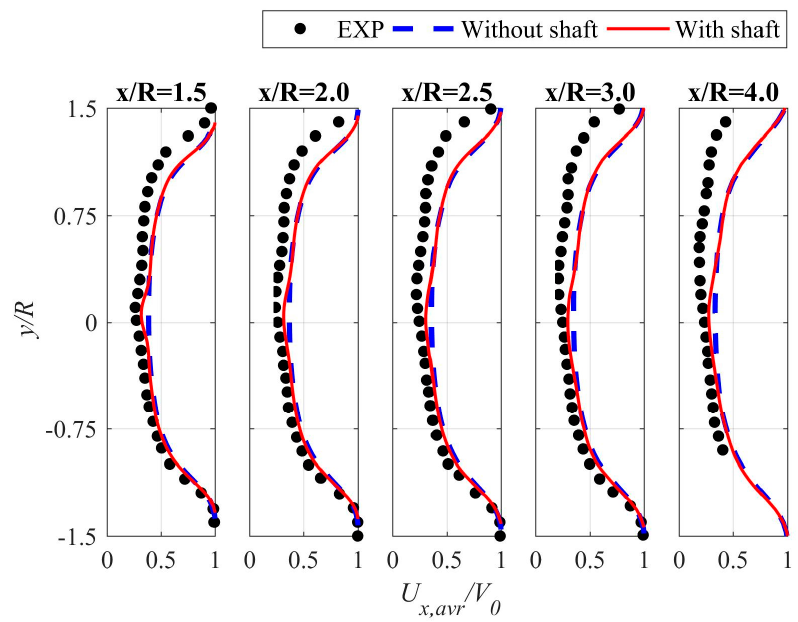
Energies 2019 , 12 , x FOR PEER REVIEW Figure 6. Velocity profiles of the U x component at a few x / R locations downstream behind the rotor. Figure 6. Velocity profiles of the U x component at a few x/R locations downstream behind the rotor.